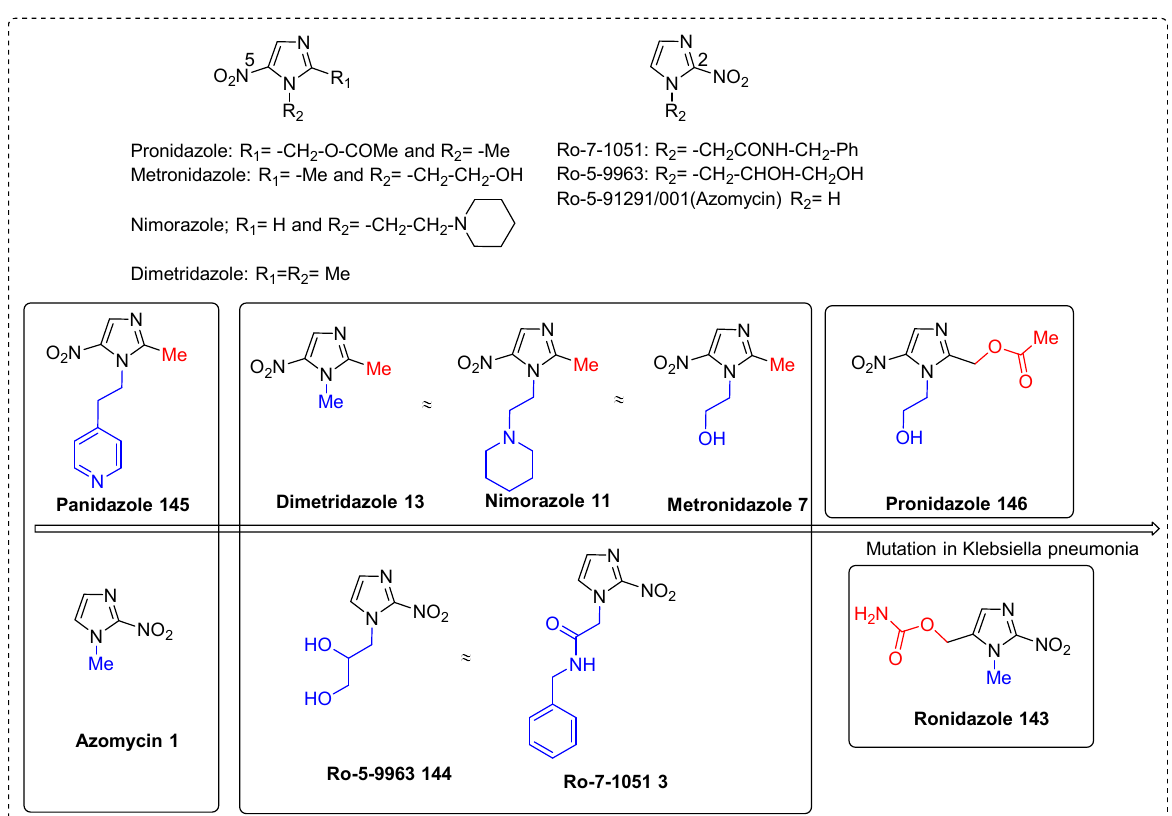
Figure 28. Mutagenic properties of a series of two substituted 5-nitroimidazole derivatives. Arredondo et al. prepared and tested for their antimicrobial activity as well as for mutagenicity ( Salmonella typhimurium reverse mutation). To achieve this, series of 21 1-methyl-2-substituted 5-nitroimidazole derivatives were synthesized with the general formulas I ( 147 ) and II ( 148 ) compared with metronidazole (Figure 29) [215].